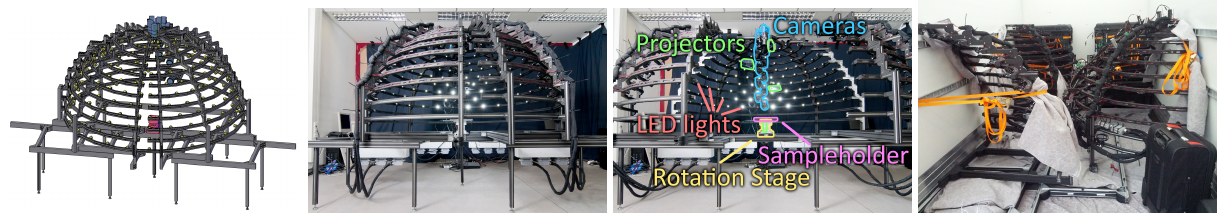
Figure 14. From left to right: The Dome 2 setup as a schematic illustration, photographed in the closed and fully opened configuration as well as disassembled and packed into a light commercial